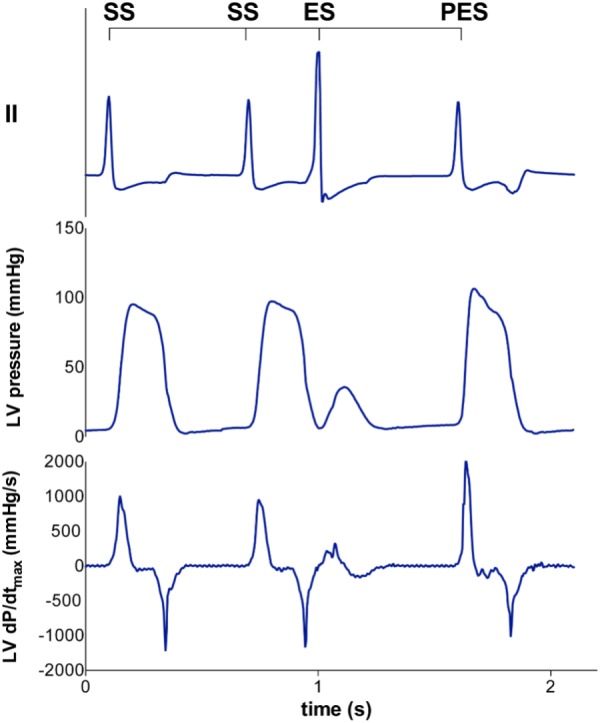
Representative tracing of LV pressure and LV dP/dtmax of the extrasystolic and postextrasystolic beat. A steady state stimulation train (SS) is interrupted with an extrasystolic beat (ES) at different coupling interval (CI), followed by a post-extrasystolic beat (PES) at a fixed CI. With decremental CI of the ES, the LV dP/dtmax of the ES decreases, while the LV dP/dtmax of the PES increases.